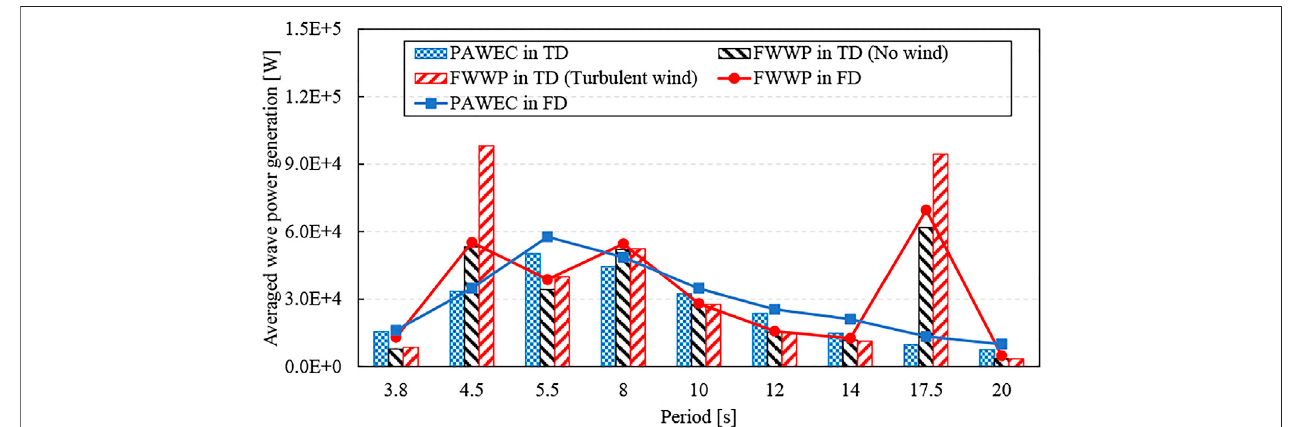
FIGURE 14 | Wave power generation of the PAWEC and FWWP in the frequency and time domain.